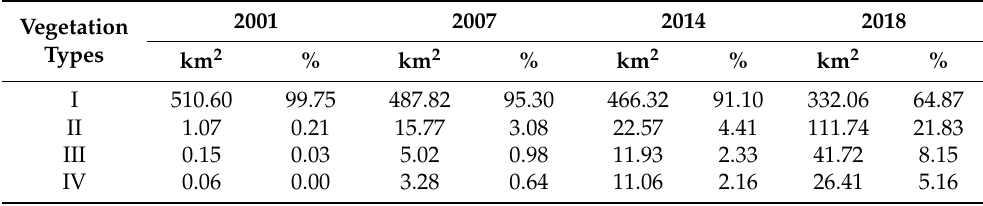
Table 2. Vegetation coverage areas of different classes in 2001, 2007, 2014, and